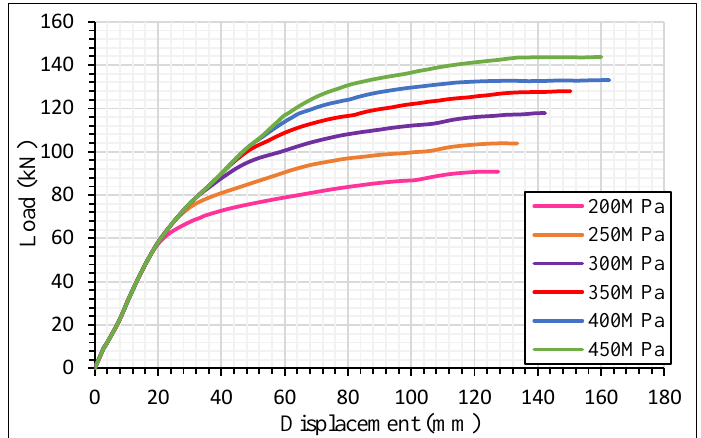
Figure 21. The steel beam yield stress on the load-deflection curve